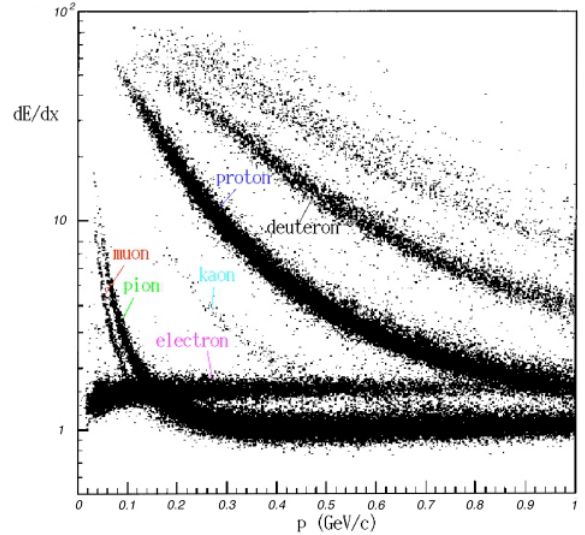
describes design studies for the pion capture and phase rotation channel. Prospects for polarized muon beams are discussed in detail. The section concludes with an outline of an R&D program for target and phase rotation issues.